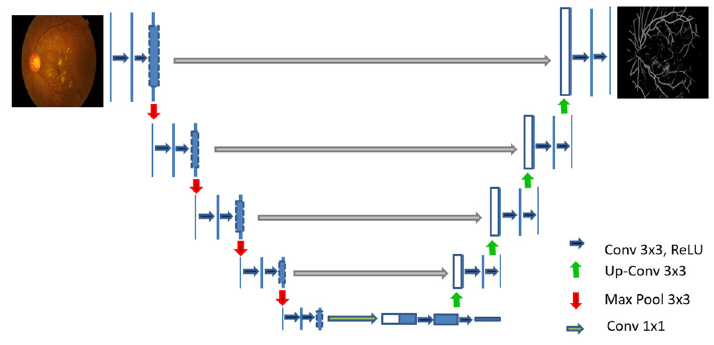
Figure 1. U-Net architecture for blood vessel segmentation.